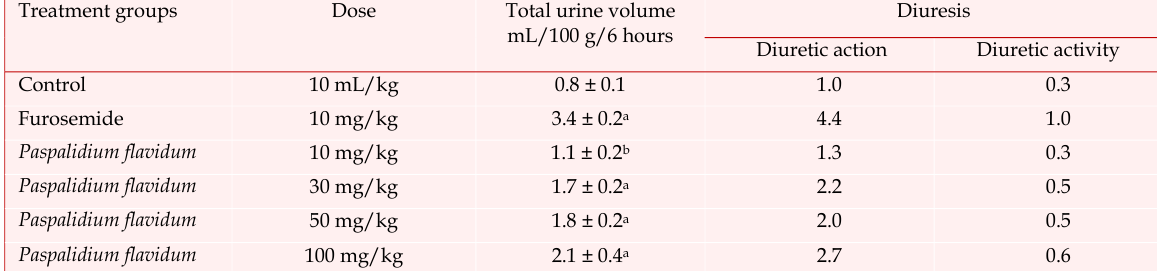
Diuretic effects of aqueous methanolic extract of Paspalidium flavidum in rats Treatment groups